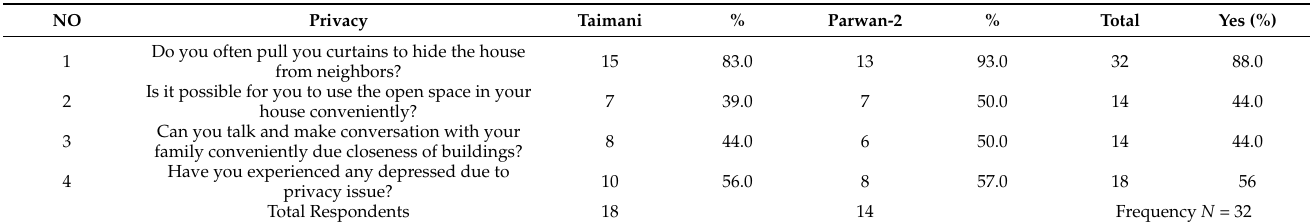
Table 8. Residents view regarding